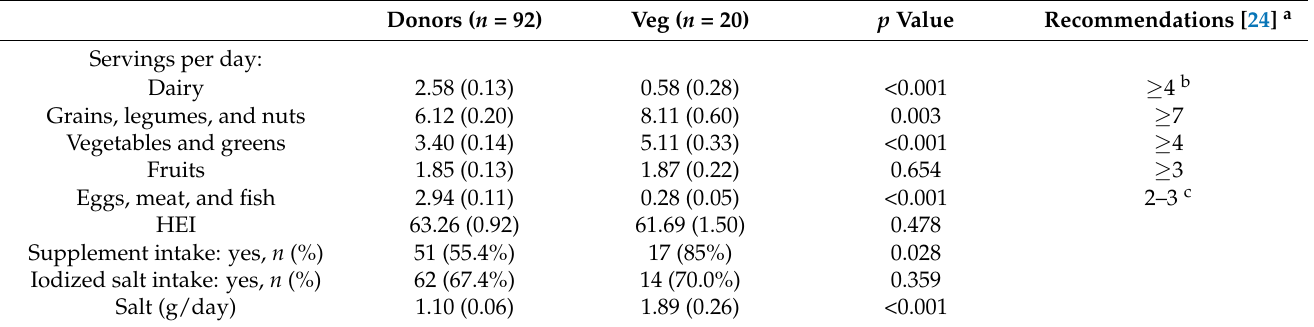
Table 7. Diet survey: five-day dietary diaries. Number of food servings per day consumed by the participants, healthy eating index (HEI), and records of supplement and iodized salt intake of the omnivore human milk donors with full-term infants (Donors) and vegetarian/vegan lactating mothers (Veg).